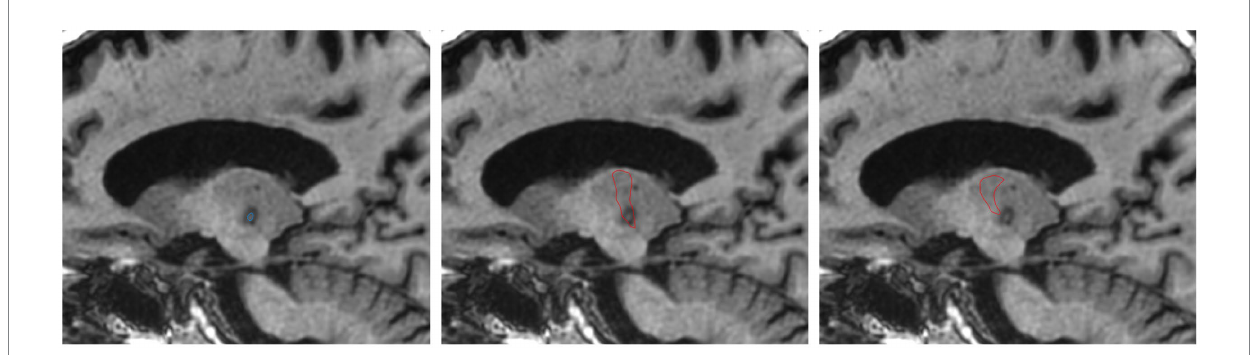
FIGURE 1 Example of ablation core segmented on T1-WI acquired 1 day post-treatment (left). FreeSurfer segmented VLp overlayed on day 1 T1-WI (middle). THOMAS VLp overlayed on day 1 T1-WI